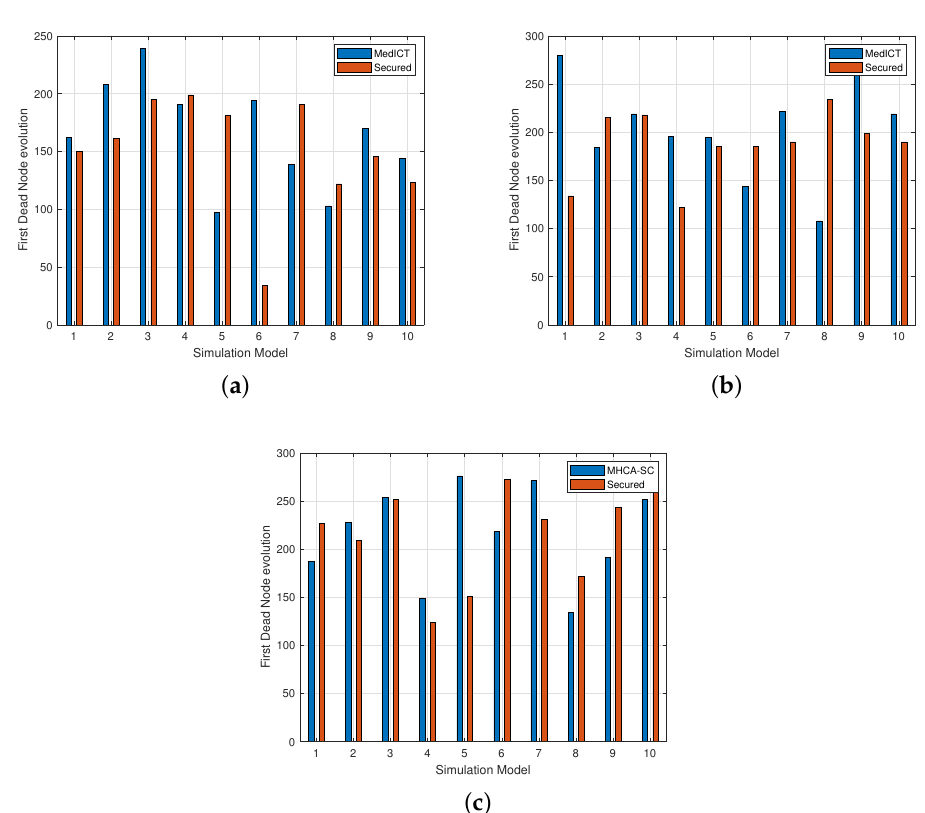
Figure 9. FDN evolution. ( a ) 300-node model. ( b ) 400-node model. ( c ) 500-node model.